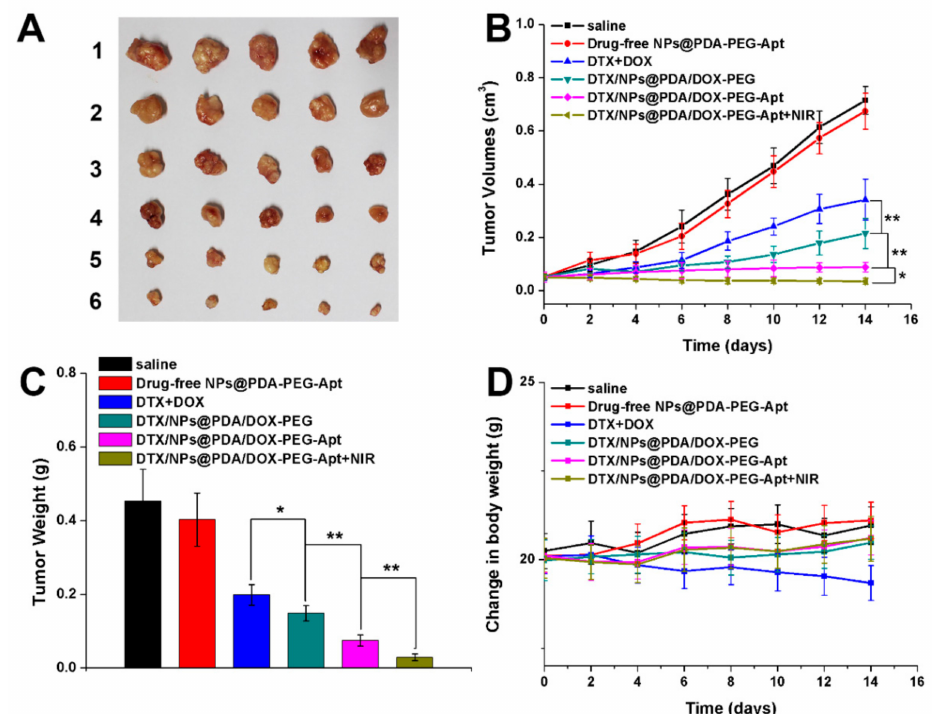
Figure 9. In vivo antitumor e ff ect of di ff erent therapies on the MCF-7 cells xenograft-bearing mice ( n = 5). ( A ) Morphology of tumors of the sacrificed mice after treatment. The numbers 1–6 refer to saline, drug-free NPs@PDA-PEG-Apt, DTX + DOX, DTX / NPs@PDA / DOX-PEG,